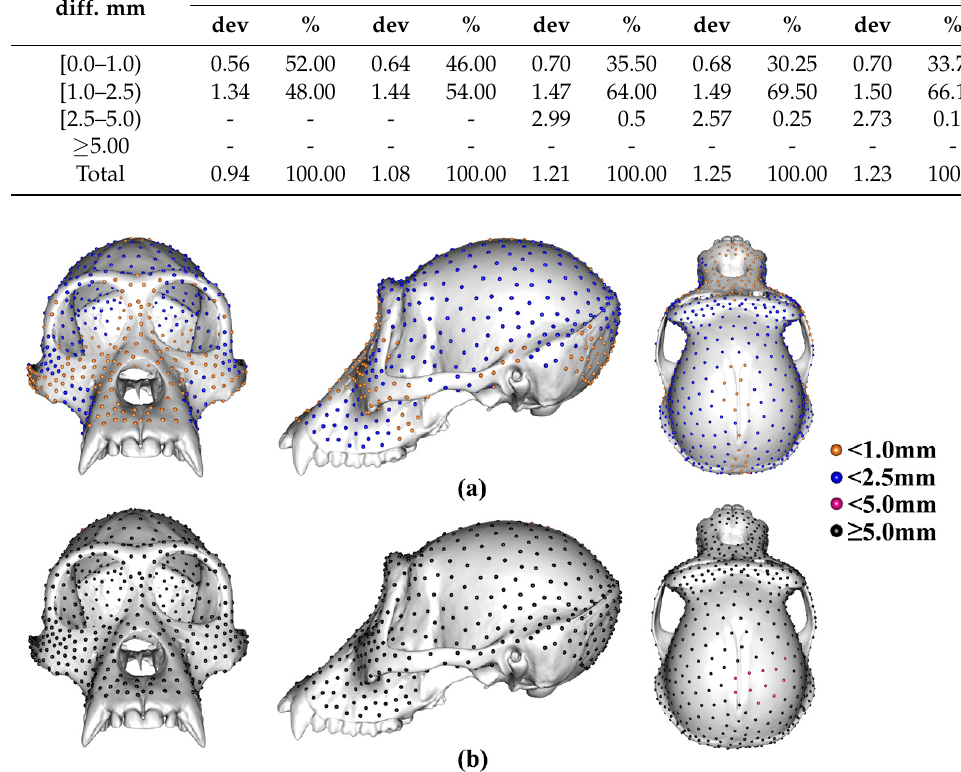
Figure 3. The average differences in location (mm) between 800 semilandmarks generated by different approaches. ( a ) Differences between sliding TPS and TPS&NICP approaches. ( b ) Differences between sliding TPS and LS&ICP approaches. Differences between TPS&NICP and LS&ICP approaches are not shown because they are very similar to those in ( b ). Table 2. Comparison of semilandmarks from sliding TPS and LS&ICP approaches.